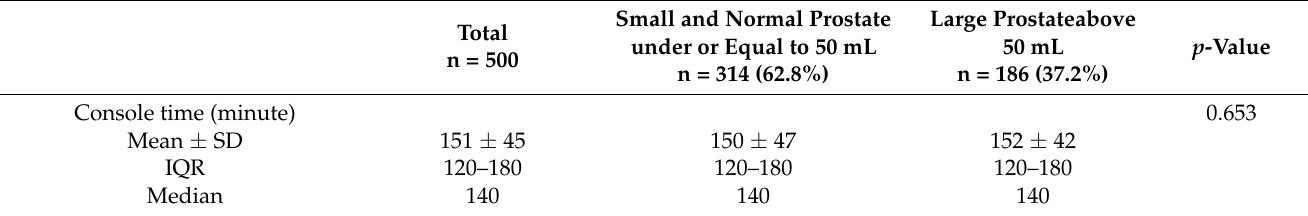
Table 2. Intra- and postoperative data and pathological findings for all